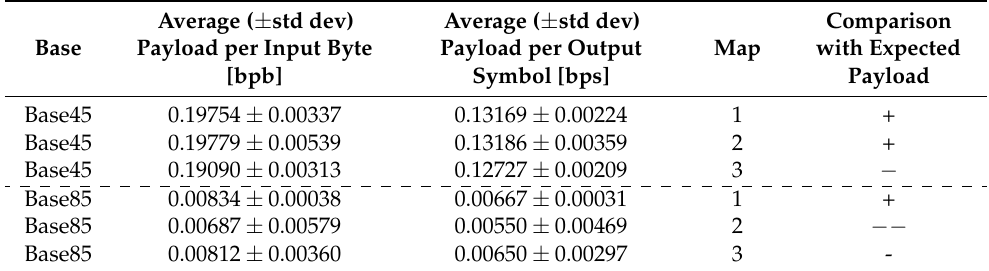
Table 4. Results of the Base45 and Base85 encodings applied to 500 PNG colour images (average image size 1017.8 KB).